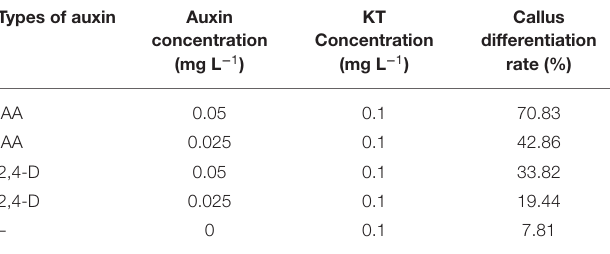
TABLE 1 | Statistics of callus differentiation rate of cotton YZ-1. Types of